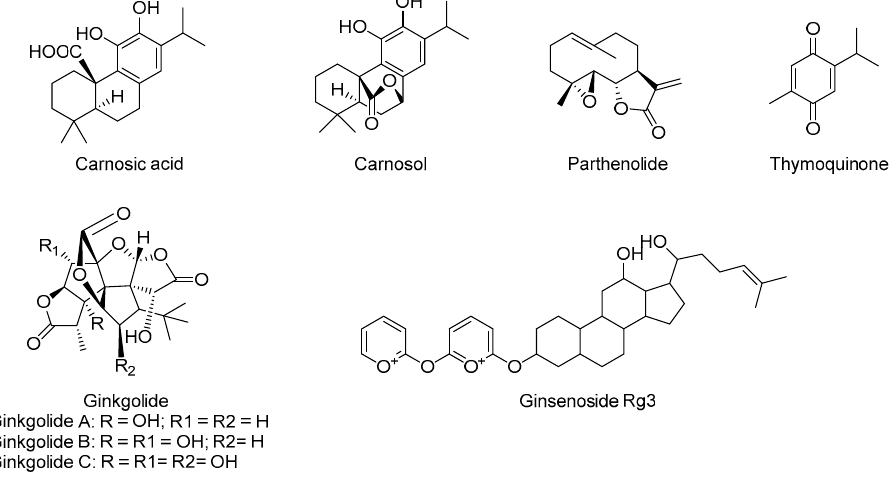
Figure 7. Chemical structure of natural terpenes with anti-inflammatory